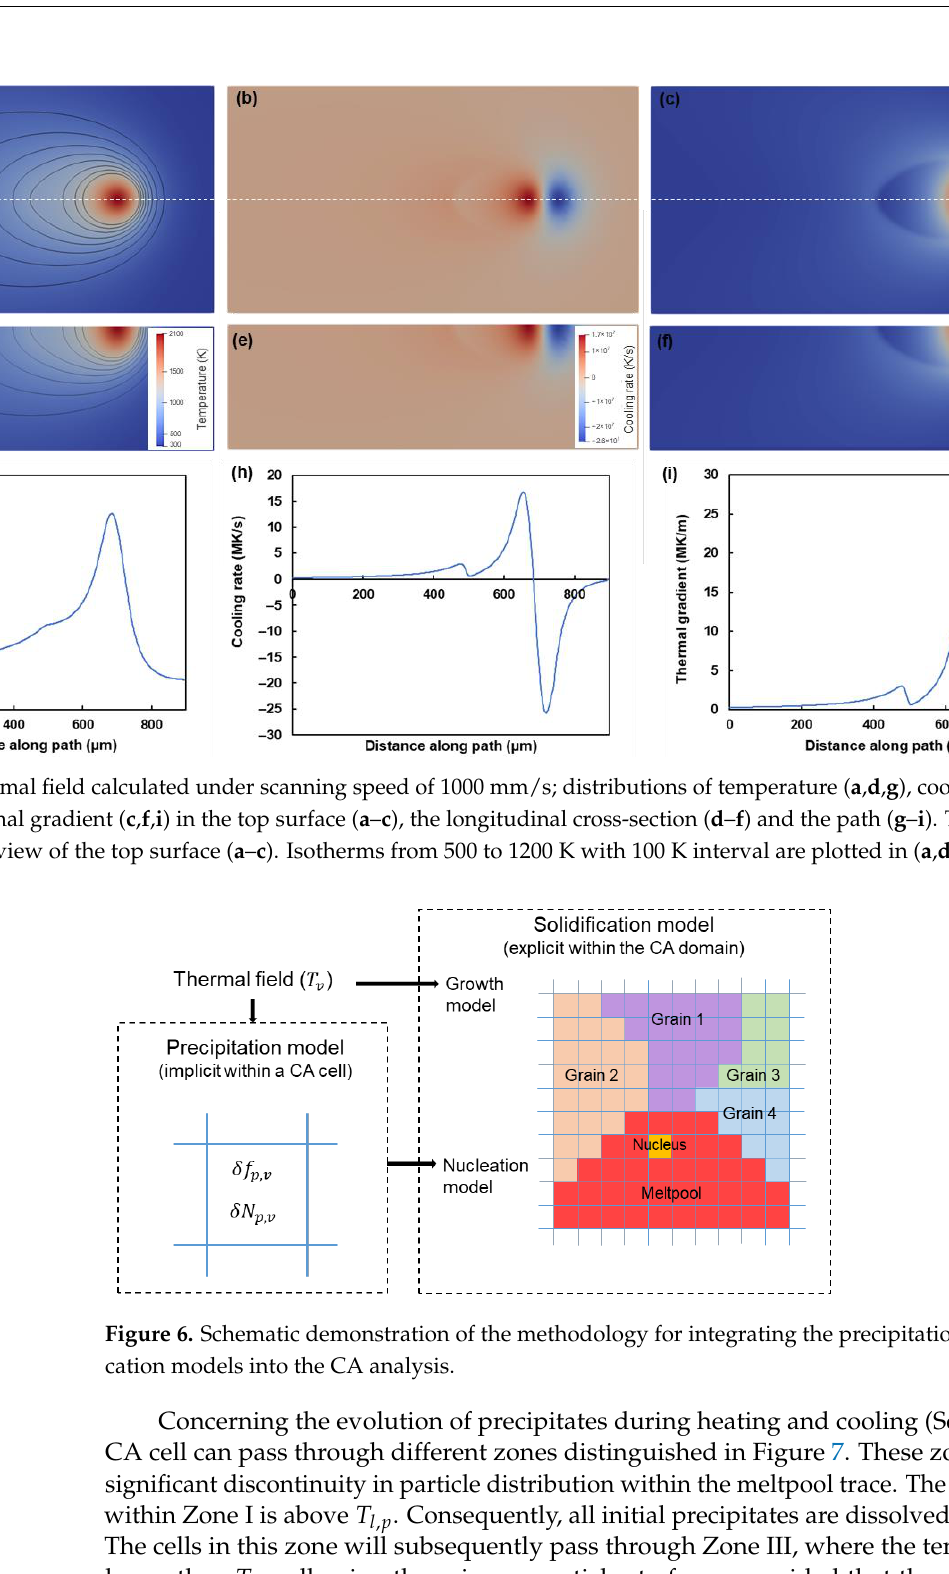
Figure 6. Schematic demonstration of the methodology for integrating the precipitation and solidi- fication models into the CA analysis.